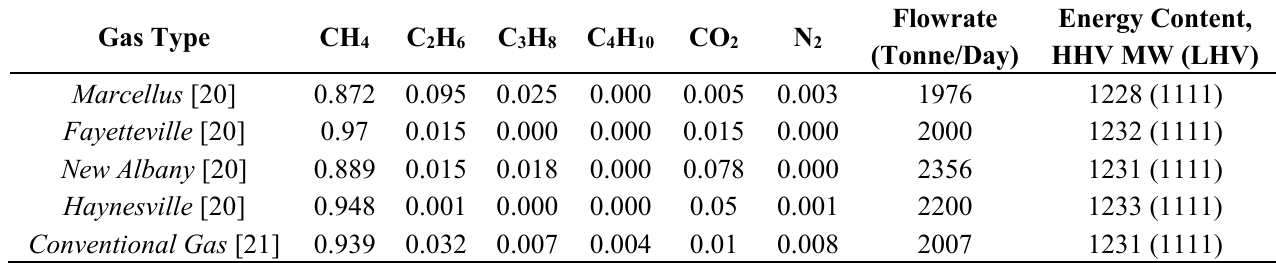
Table 1. Gas feedstocks composition, (molar).